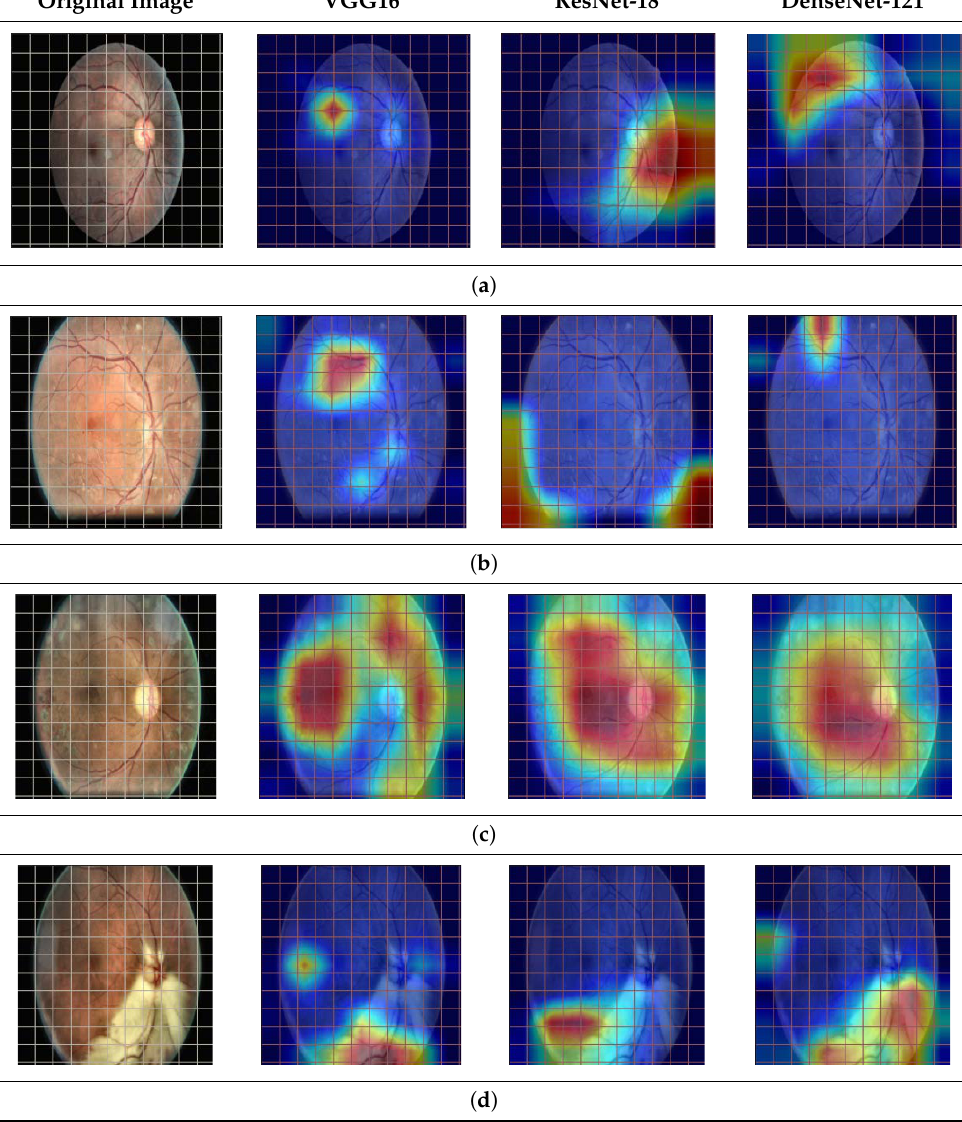
Table 5. Model conformity measures.